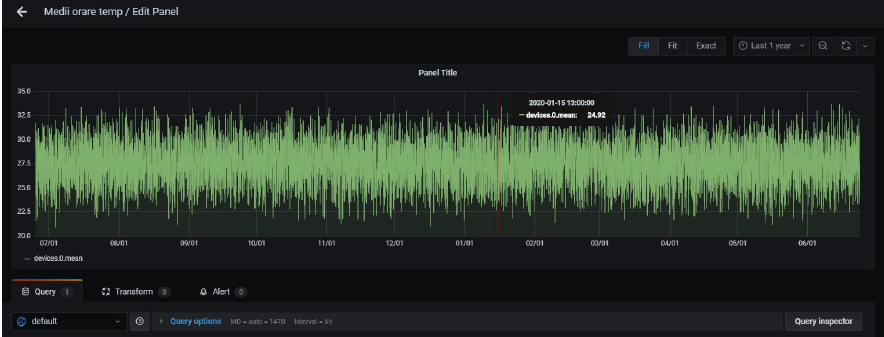
Figure 8. Representation in Grafana of the average temperature/hour in a year for a device.